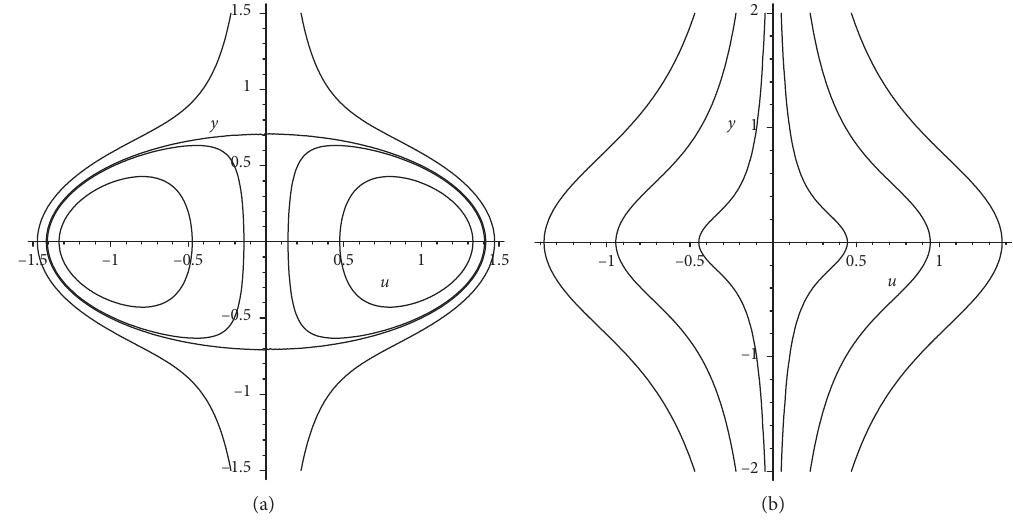
Figure 1: Phase portraits of system (9) when c � − 1 , g < 0. (a) g < 0. (b) g �